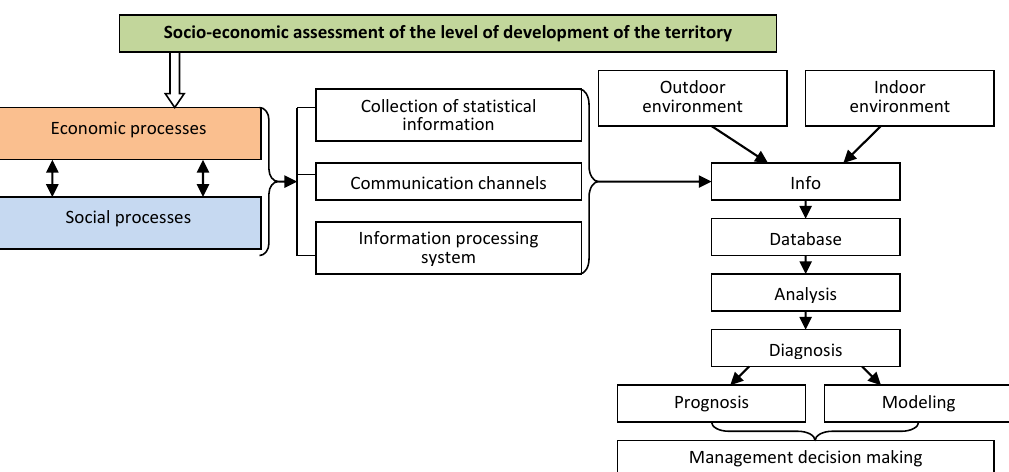
Fig. 4: Components of the assessment of the level of socio-economic development of rural areas